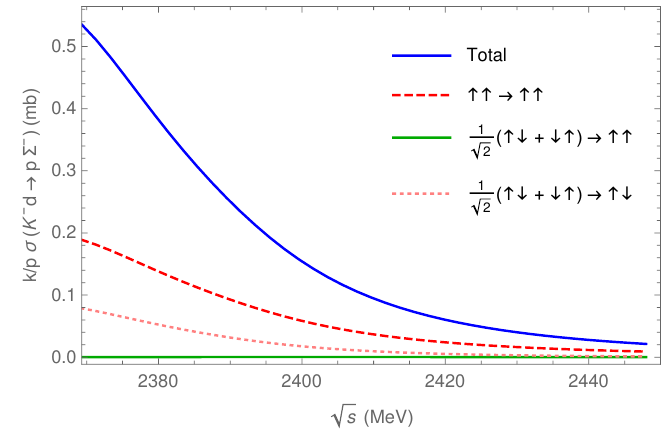
√ s and p are the total CM energy and σ . Here, p